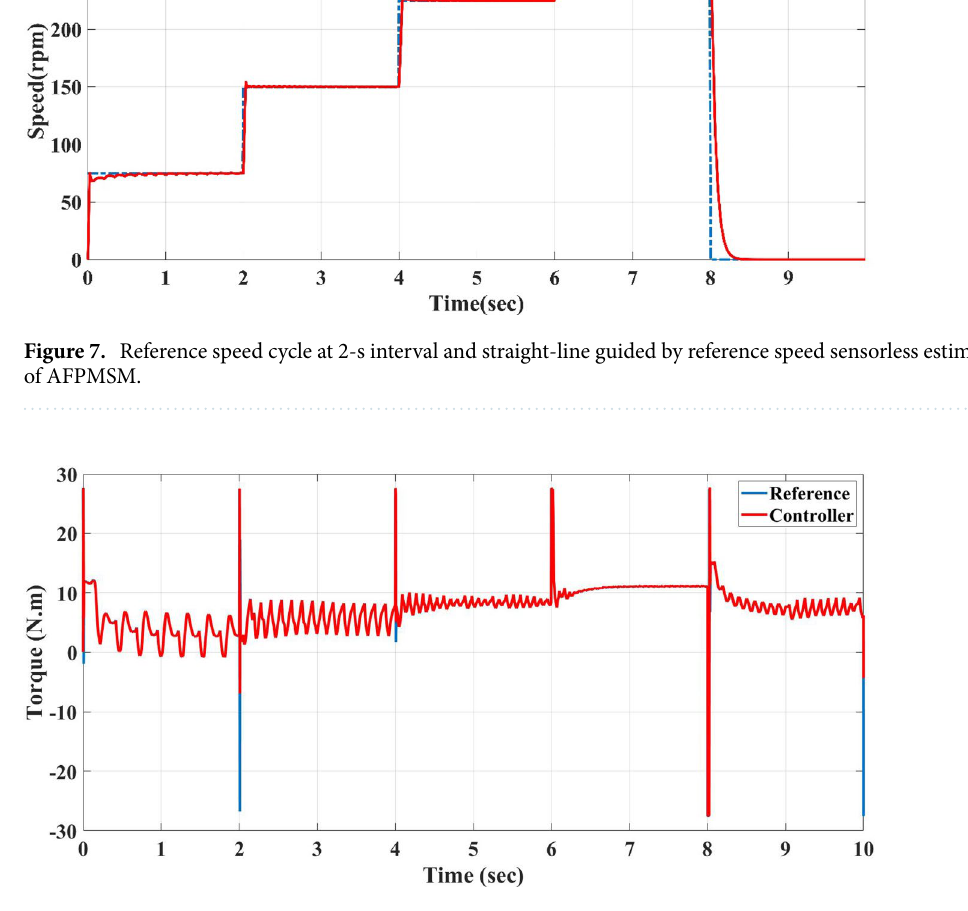
Figure 8. The AFPMSM torque response to the reference torque of DTC control.